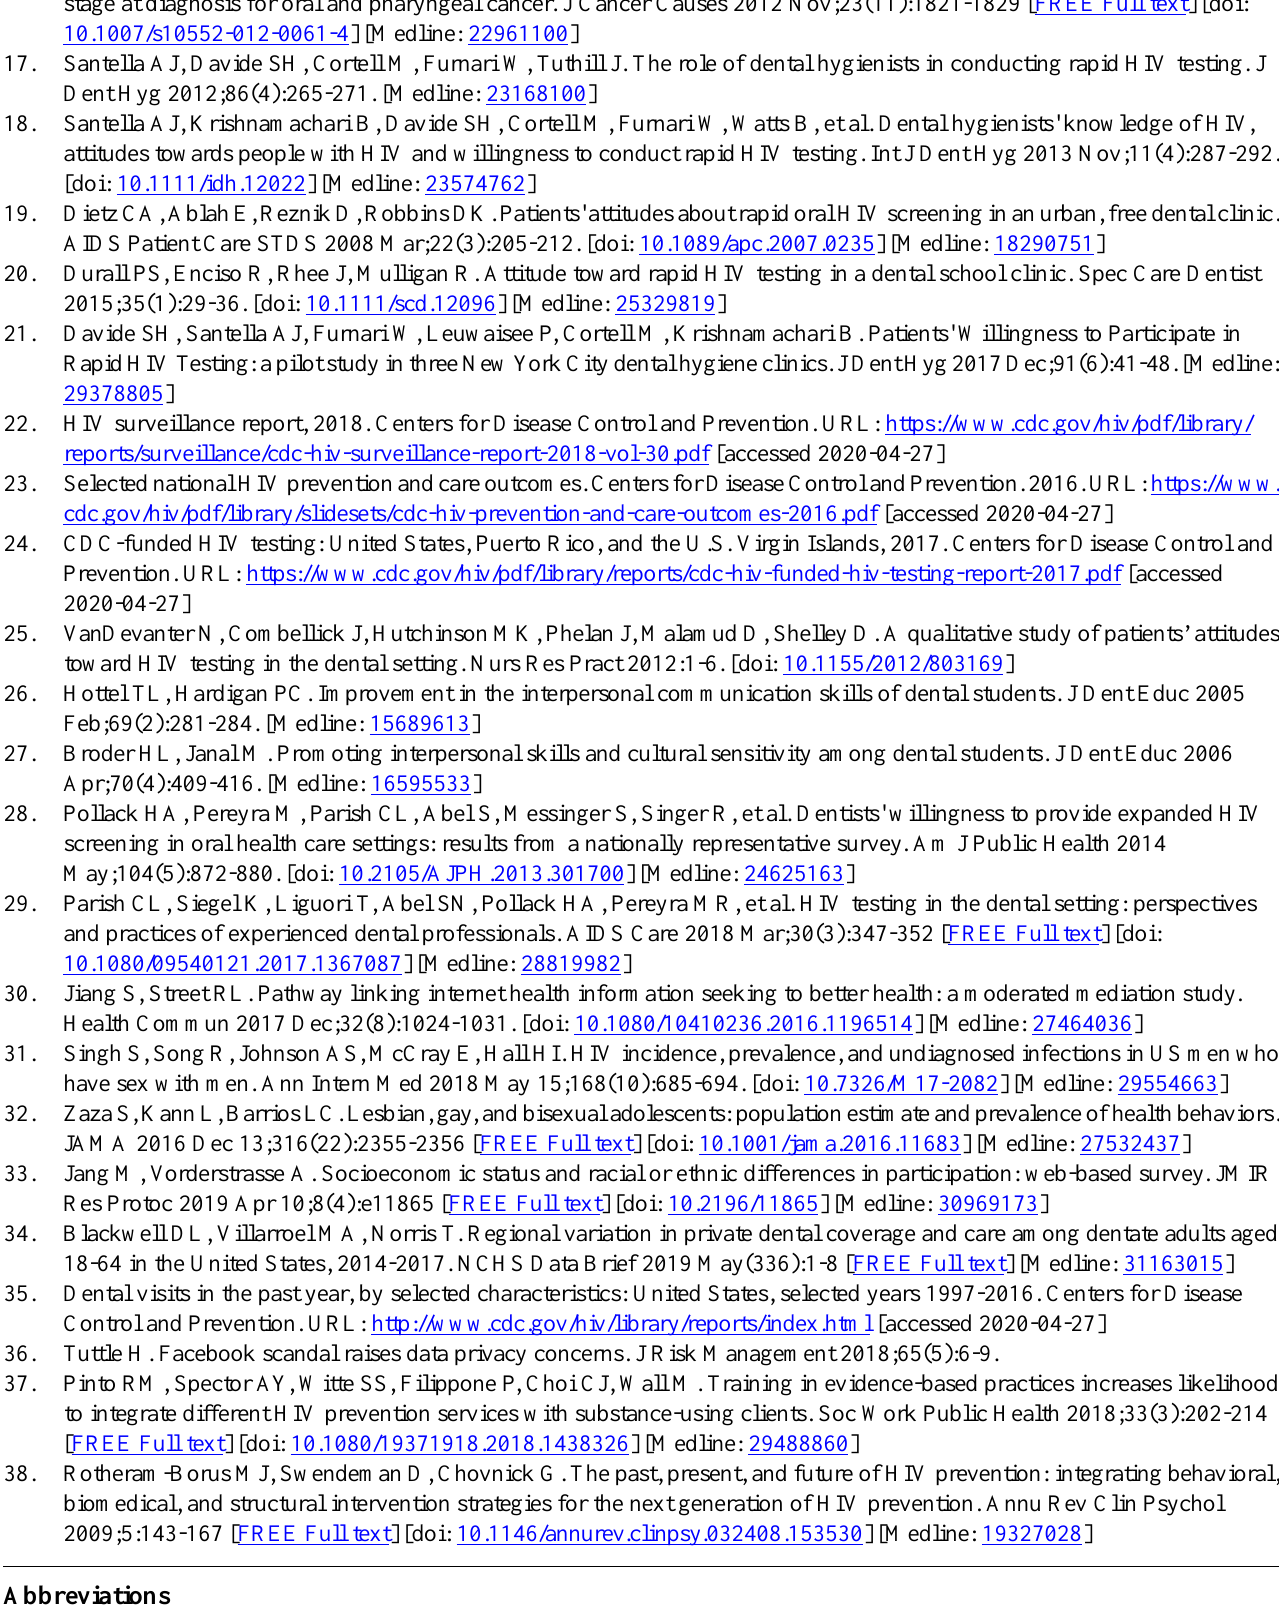
aOR: adjusted odds ratio CDC: US Centers for Disease Control and Prevention FDA: US Food and Drug